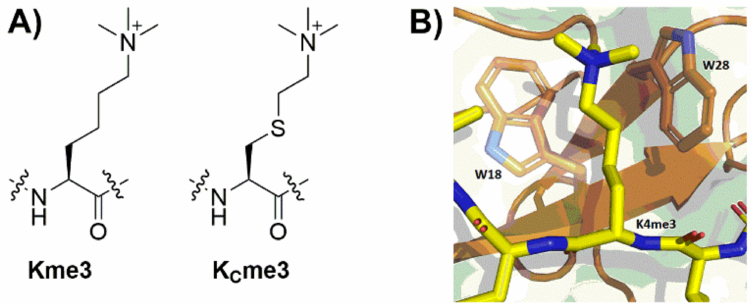
Figure 1. ( A ) Structures of of trimethyllysine ( Kme3 ) and trimethylthialysine ( K c me3 ); ( B ) view of the KDM5A PHD3 (orange) structure complexed with histone H3K4me3 (yellow) (PDB ID: